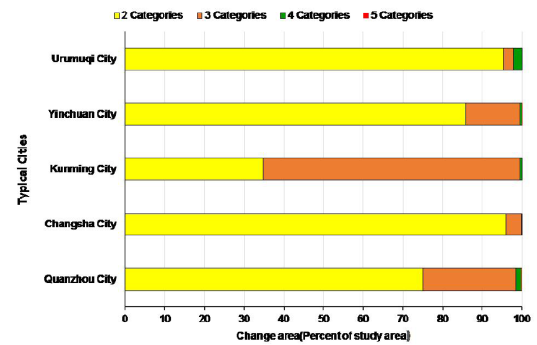
Figure. 8 The States changes in land use